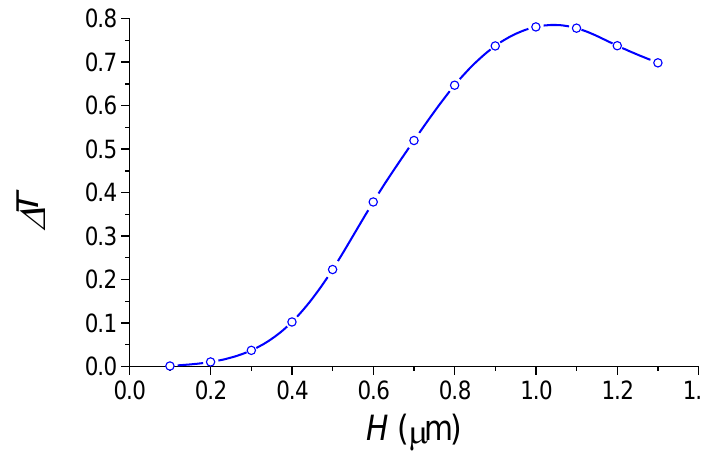
Figure 11. Dependence on the segmented width H of the transmitted power in silicon waveguide at the blocking wavelength. M = 256, W = 1.0 µm, h = 0.25 µm, w = 0.45 µm, d = 0.1 µm. Simulation made by 2D FDTD.